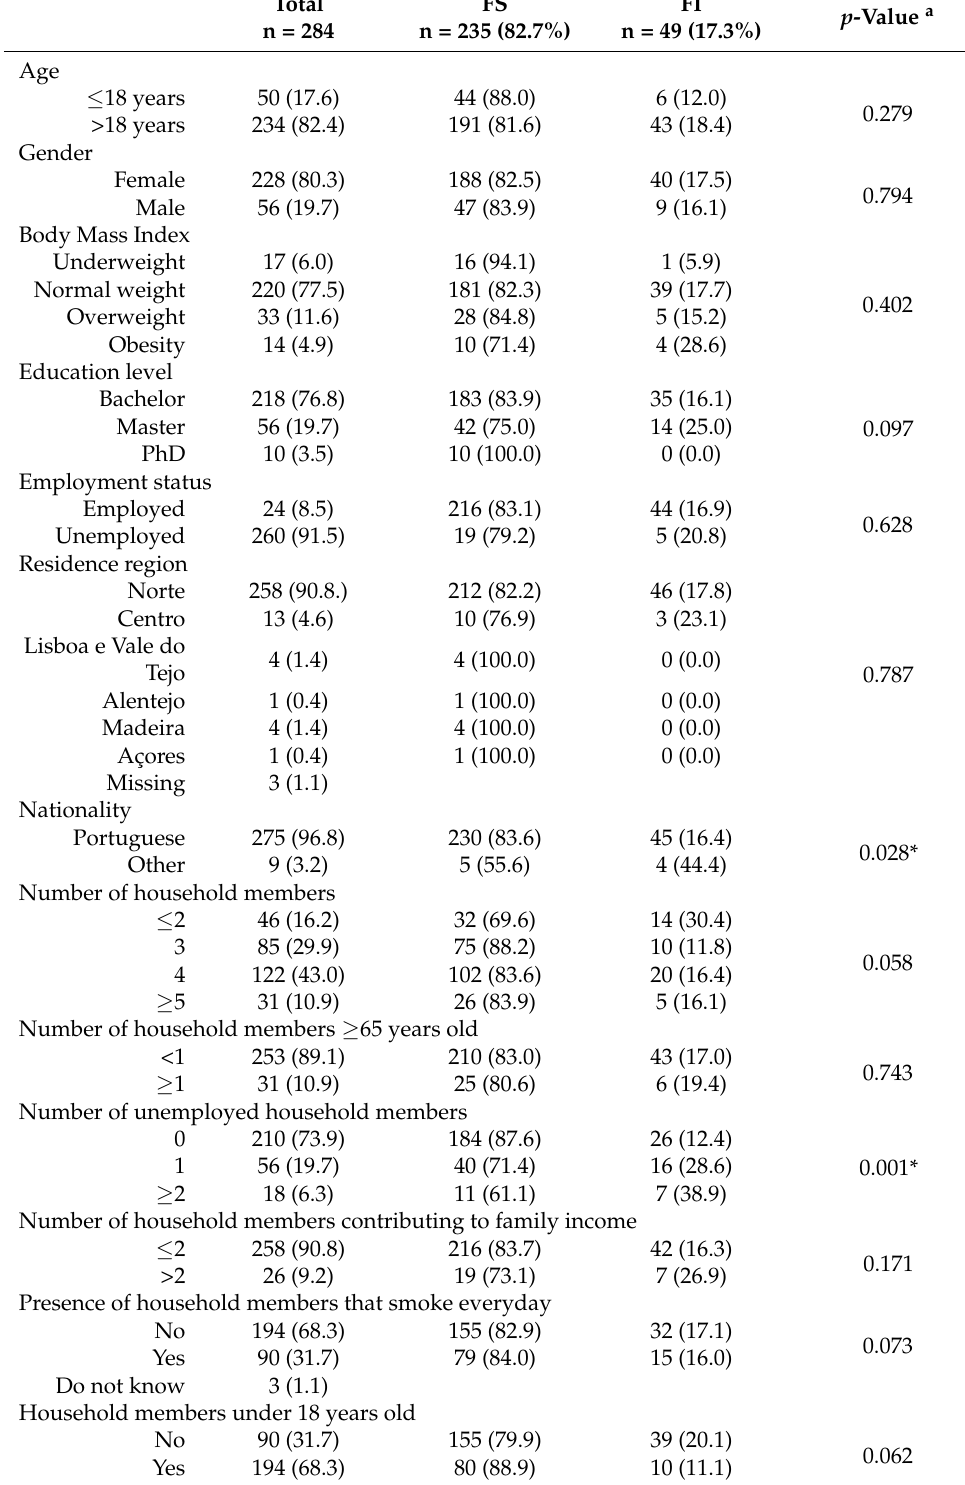
Table 3. Socioeconomic and demographic characterization of the